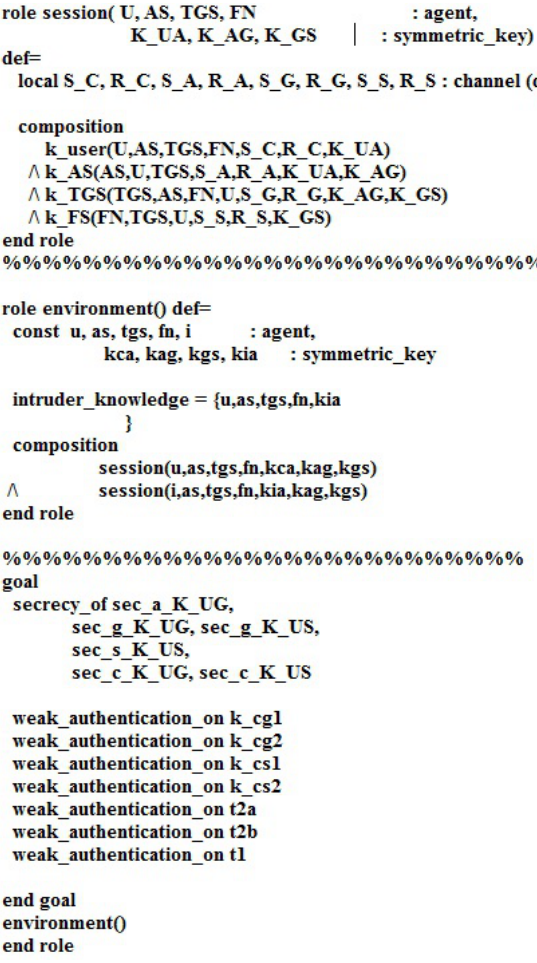
Figure 10. The session, goals, and environment roles in